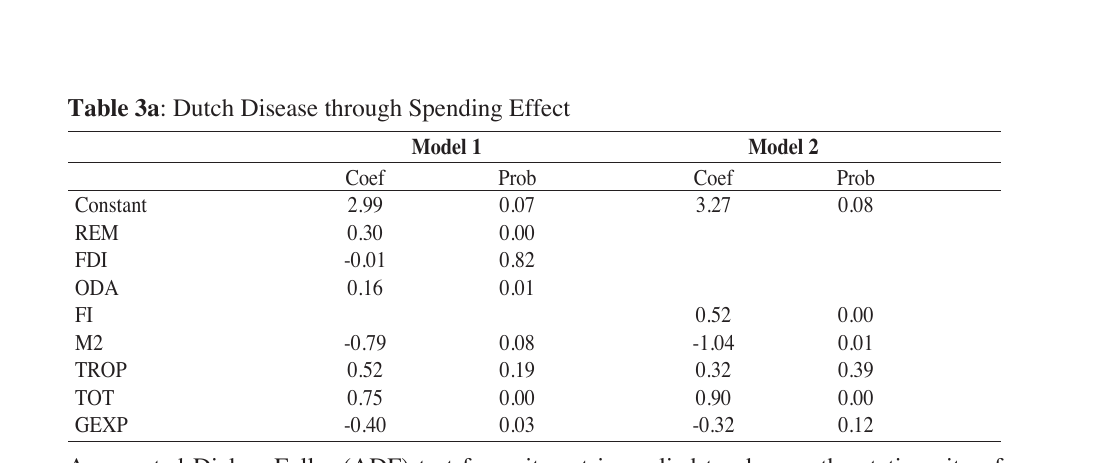
Table 3a : Dutch Disease through Spending Effect